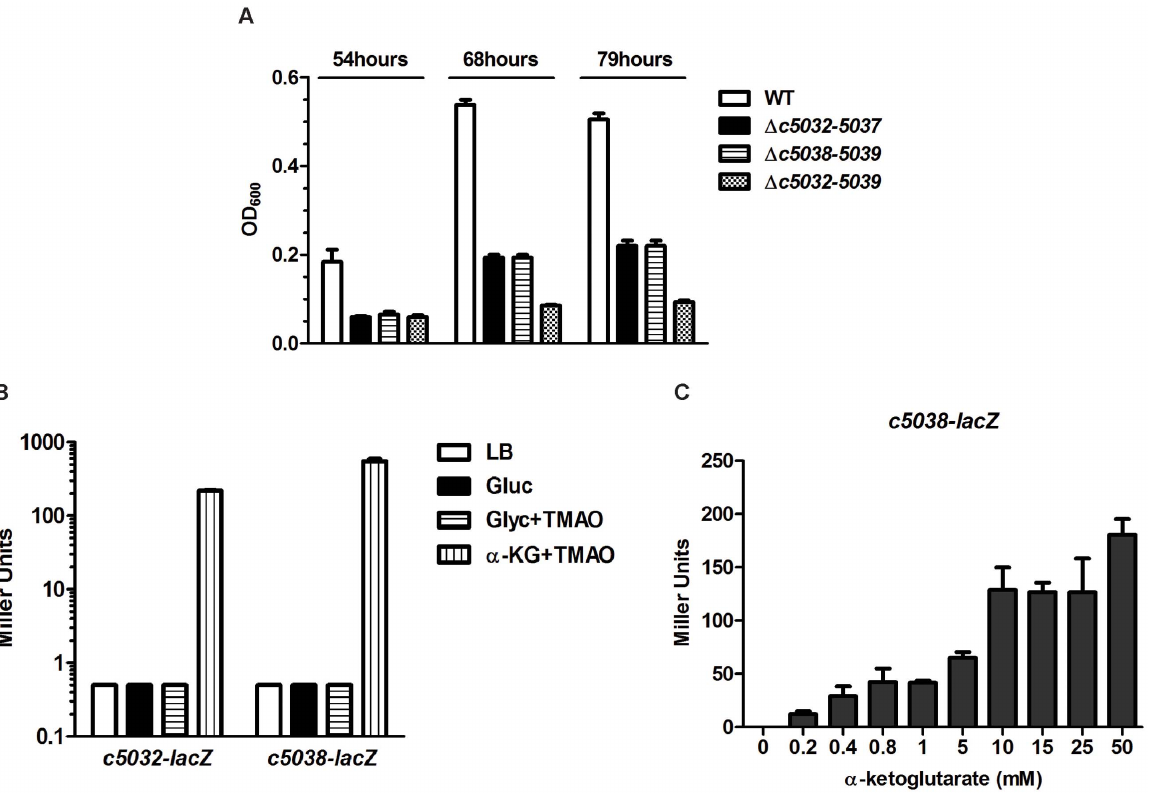
Figure 5. Contribution of c5032 - 5039 to growth on a -KG and induction of c5032 - lacZ or c5038 - lacZ expression by a -KG. (A) In vitro growth of island gene mutants in M9 medium containing a -KG as the sole carbon and energy source. Optical density of the CFT073 WT and mutants during growth in M9 medium containing a -KG as the sole carbon source under anaerobic conditions was determined. Growth bars represent the average measurement at each time point from triplicate experiments. (B) Effects of different substrates on c5032 - lacZ or c5038 - lacZ expression. Gluc, glucose; Glyc, glycerol; TMAO, Trimethylamine N -oxide. (C) The induction of c5038 - lacZ expression by a -KG is dose-dependent. Bacteria were grown in M9 medium containing 0.25% glycerol as the sole carbon source plus different amounts of a -KG as stimulus under anaerobic conditions.